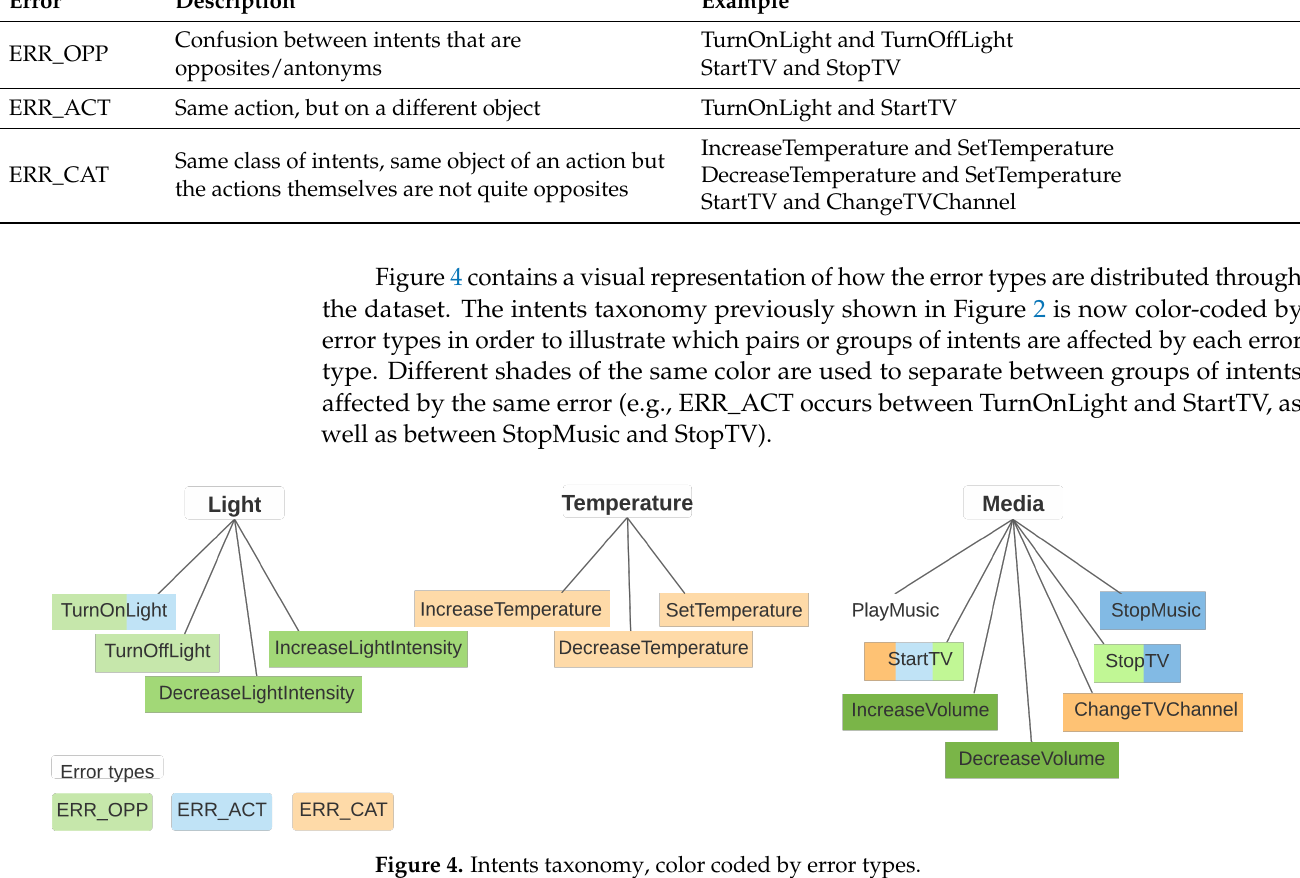
Figure 4. Intents taxonomy, color coded by error types.